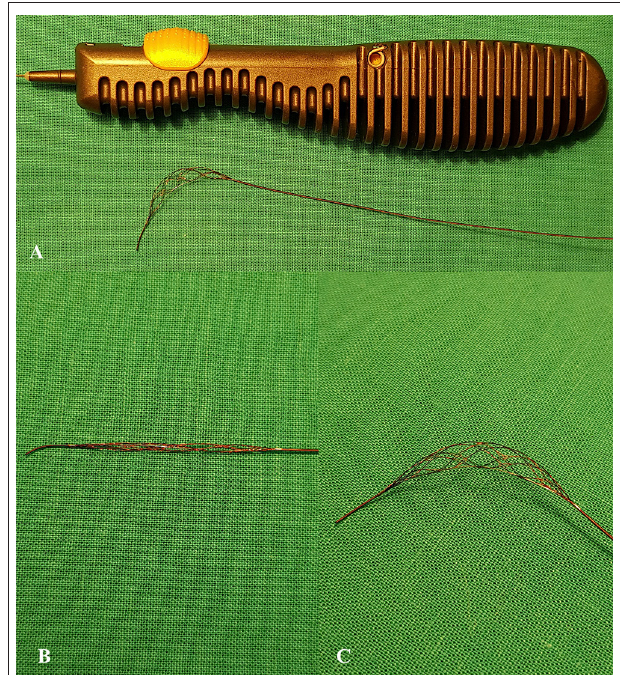
FIGURE 1 | (A) Tigertriever device with open mesh structure using integrated handle slider. Magnified images of the Tigertriever mesh in closed (B) and open (C)